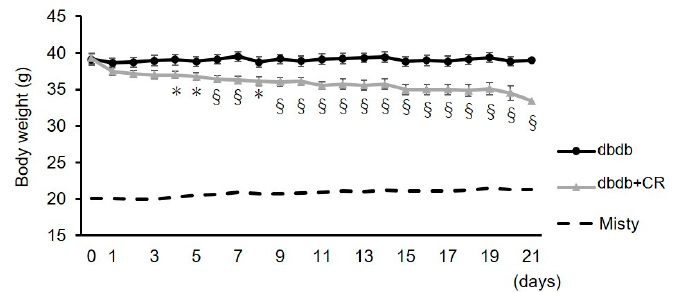
Figure 1. Changes in the body weight of rats during a 21-day dietary intervention. dbdb, ad libitum-fed control group; dbdb+CR, daily calorie restriction group. Data of misty mice were used as reference values (dotted lines). Data are the mean ± SEM ( n = 5). * p < 0.05, § p < 0.01 compared with the dbdb group. Table 1. Body weight, total food intake, liver weight, epididymal fat weight, and concentrations of plasma glucose and insulin in mice.